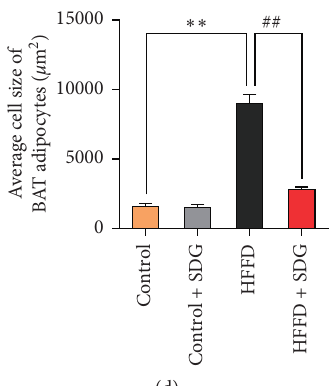
Figure 4: SDG alleviates adipose tissue hyperplasia induced by a Western diet in obese mice. (a) H&E staining ( × 200); (b) average area of white adipose tissue cells in the epididymis; (c) average area of subcutaneous white adipose tissue cells; and (d) average area of brown adipose tissue cells. Data are represented as mean ± SEM, n � 10 biologically independent animals. ∗ p < 0 . 05, ∗∗ p < 0 . 01 versus the control group; # p < 0 . 05, ## p < 0 . 01 versus the HFFD